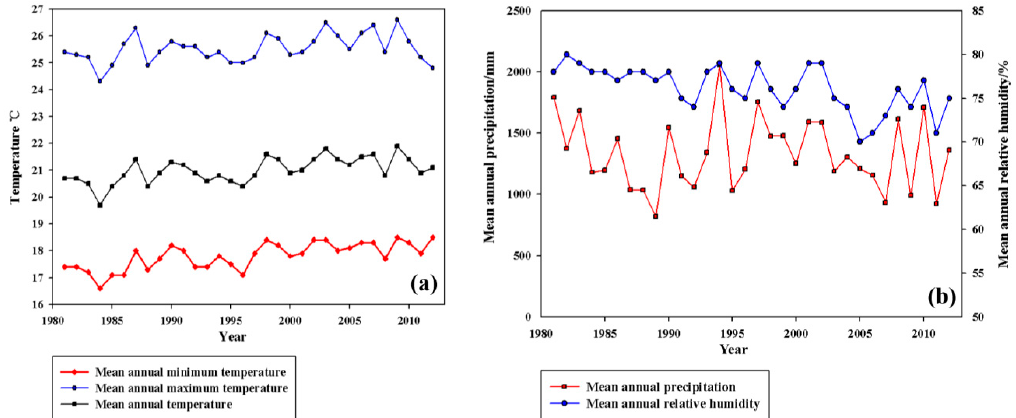
Figure 1. Climatic diagrams for experimental sites. The subfigure ( a ) shows the change trend of the mean annual minimum temperature, the mean annual maximum temperature and the mean annual temperature at the study site. The subfigure ( b ) shows the trend of the mean annual precipitation and mean annual relative humidity.